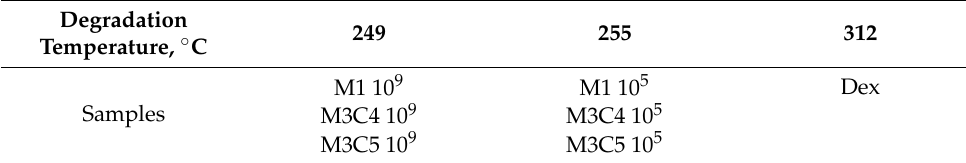
Table 3. Thermal characteristics of the studied